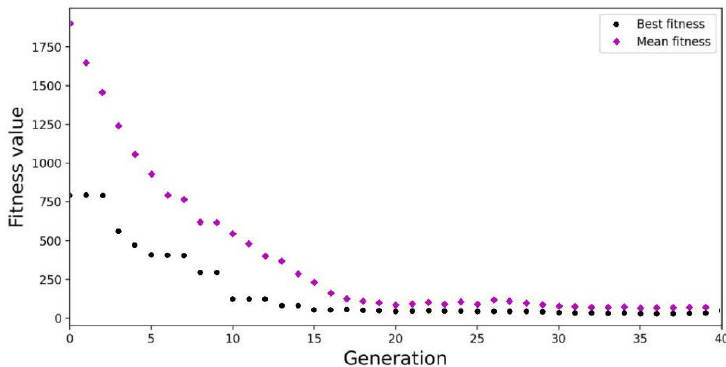
Figure 10. Convergence process of the fitness function for the best chromosome and population mean.